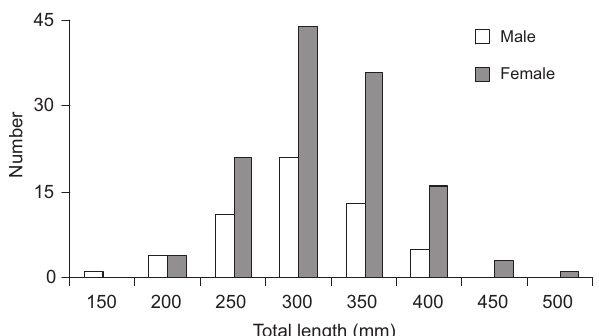
Figure 1. Length frequency distribution of males and females of H. affinis in Lajes